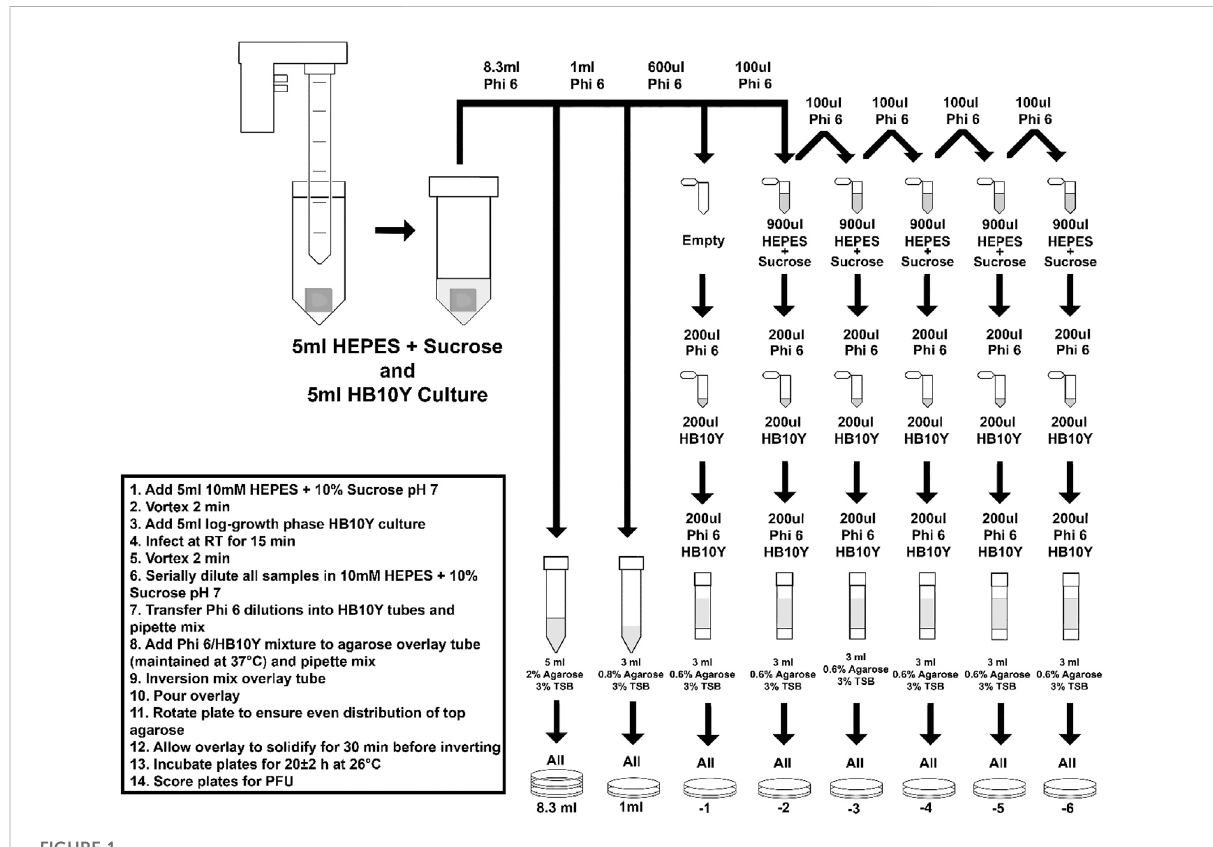
FIGURE 1 Φ 6 extraction procedure for test samples and non-treated